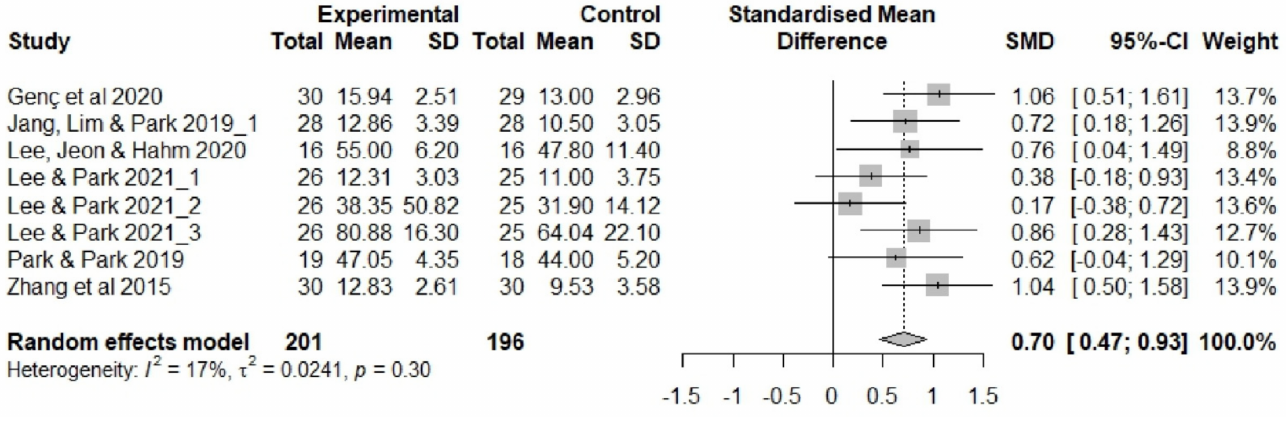
Figure 5. Forest plot showing the effects of non-pharmacological interventions (modified). SD, standard deviation; SMD, standard mean difference